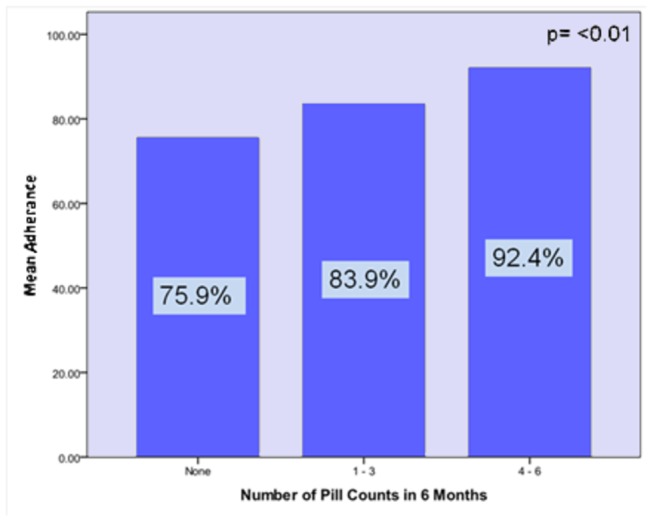
Mean Adherence by Pill Counts Category.Mean adherence in each of the three categories of pill counts performed showing increased adherence as the number of pill counts increased.